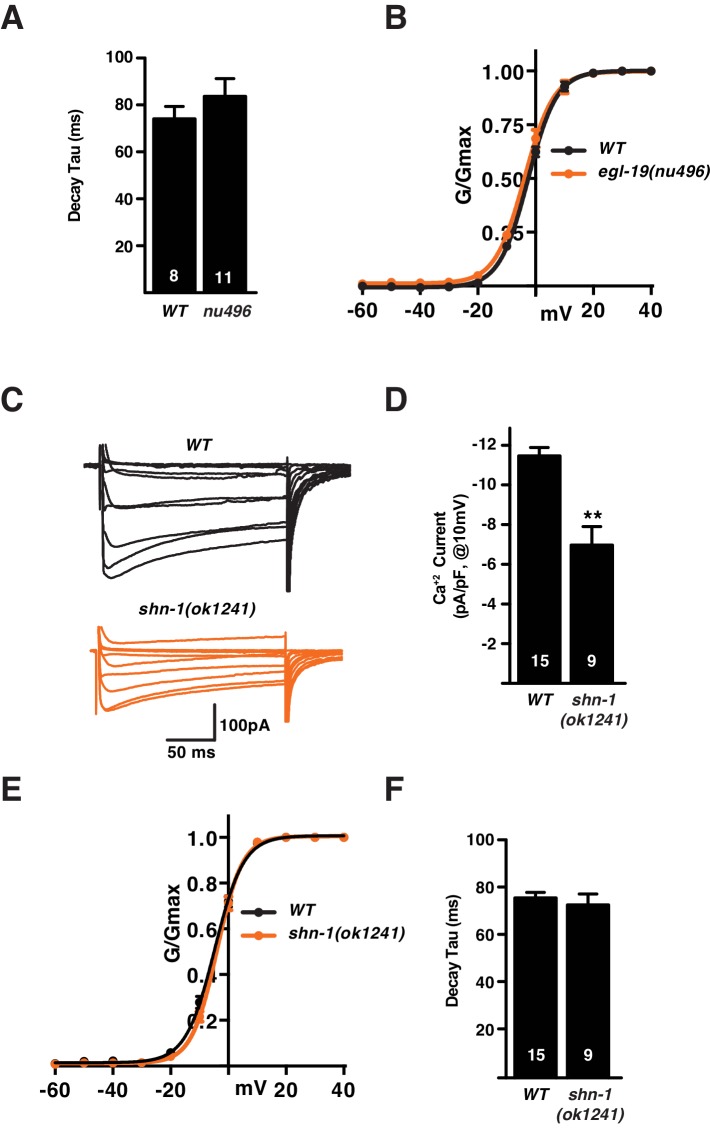
Supplemental data related to Figure 2.Deleting the EGL-19 c-terminal PDZ ligand (in nu496 mutants) had no effect on the kinetics of current deactivation (A) nor on the voltage dependence of current activation (B). Summary data are plotted for recordings shown in Figure 2. (C–F) The shn-1(ok1241) mutation, which deletes the PDZ and part of the proline rich domains (Figure 1—figure supplement 1D), decreases calcium current density (C–D) but has no effect on the voltage-dependence of current activation (E) nor on the kinetics of current deactivation (F). Values that differ significantly from wild type controls are indicated (**p<0.01, *p<0.05). Error bars indicate SEM. Mean, standard errors, sample sizes, and p values for this figure are shown in Supplementary file 1.